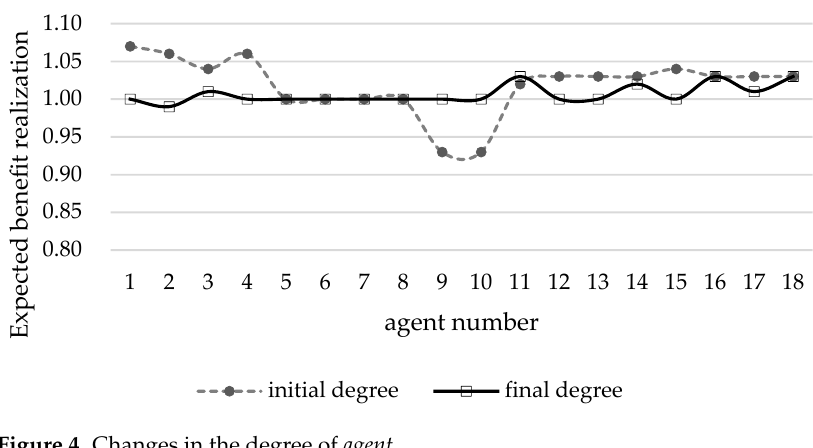
Figure 4. Changes in the degree of agent .